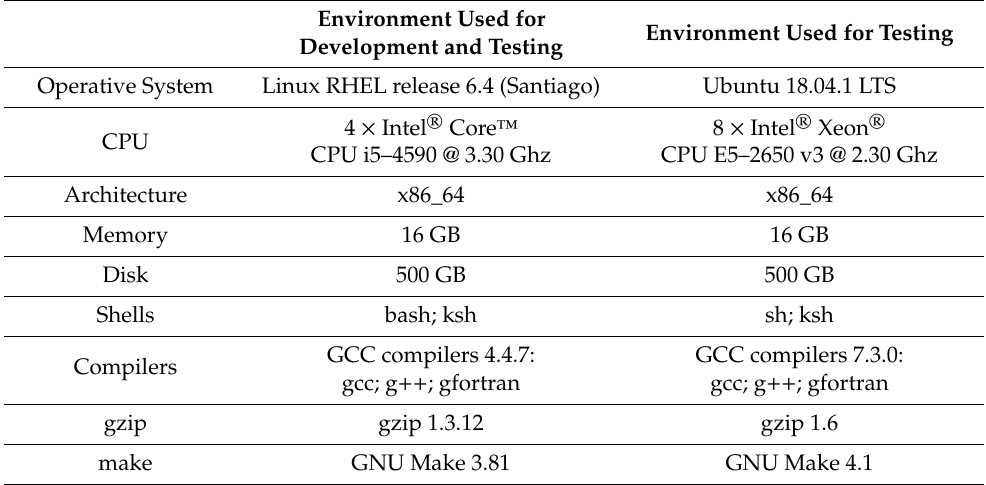
Table 8. Environments used for development and testing of NWC / GEO v2018.1 software